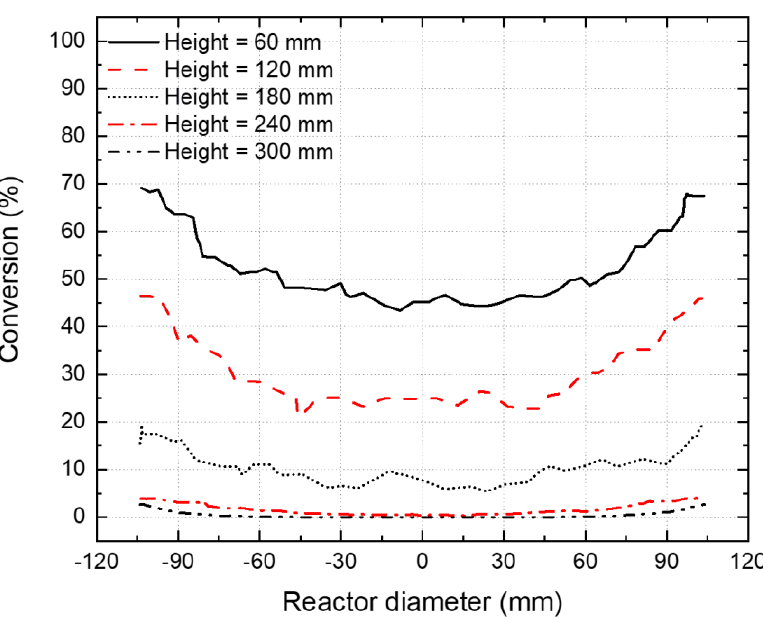
Figure 21. Methane conversion rate by height in the reactor (semi-cavity).